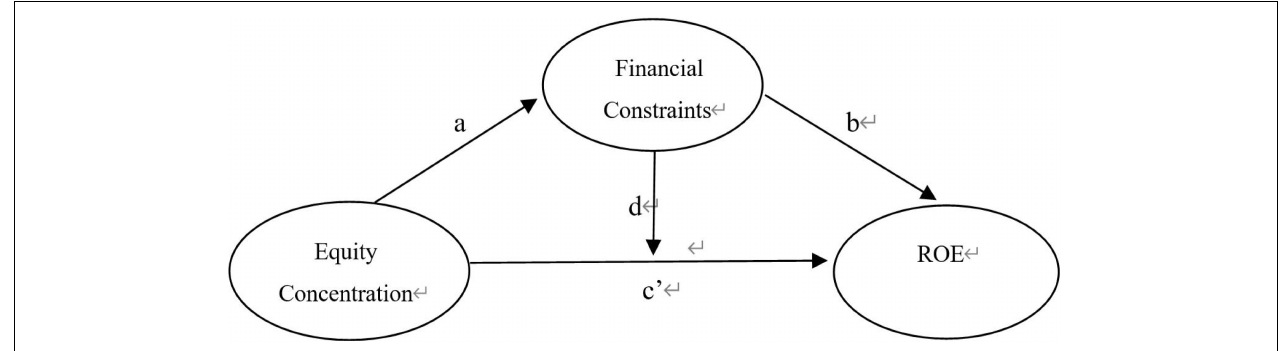
FIGURE 1 | Interactive relationship model of “Equity Structure – Financial constraints – Enterprise Performance.”